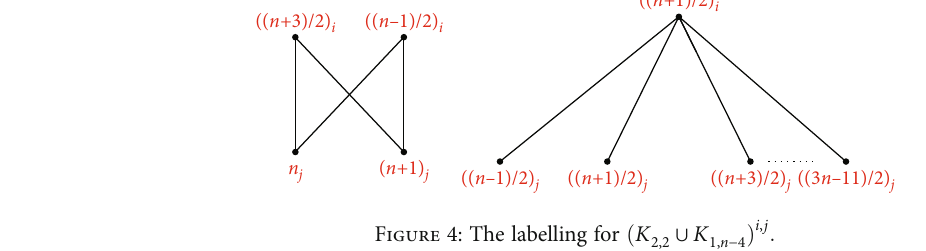
Figure 4: The labelling for ð K